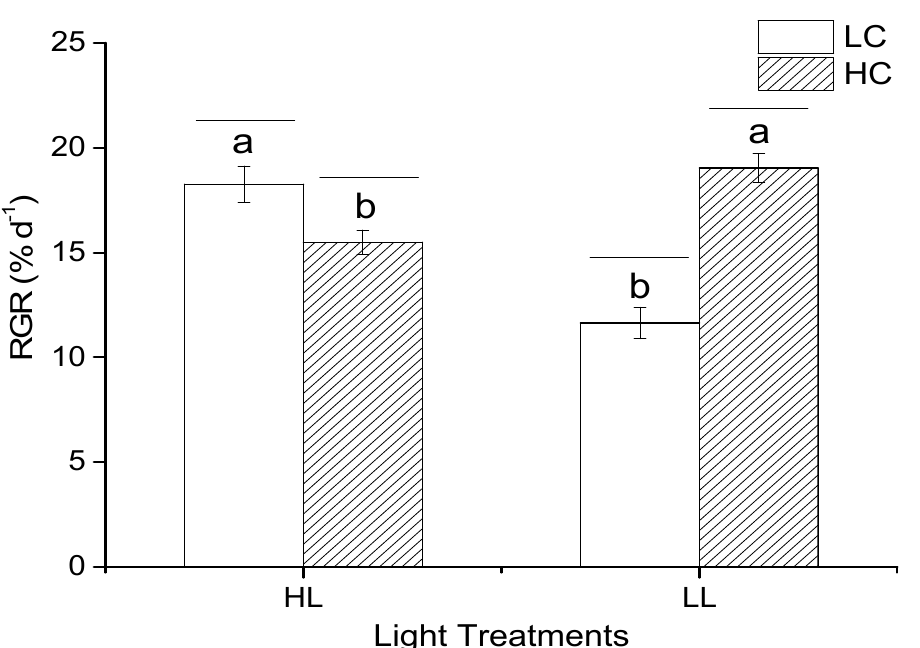
Figure 1. The relative growth rate (RGR) of Porphyra yezoensis under different CO 2 concentrations (400 μ atm, LC; 1000 μ atm, HC) and light treatments. Values show the mean ± SD. Different letters (a and b) represent significant differences ( p < 0.05) at different light treatments under the same CO 2 levels. Horizontal bars represent significant differences ( p < 0.05) between LC and HC under same light treatments.